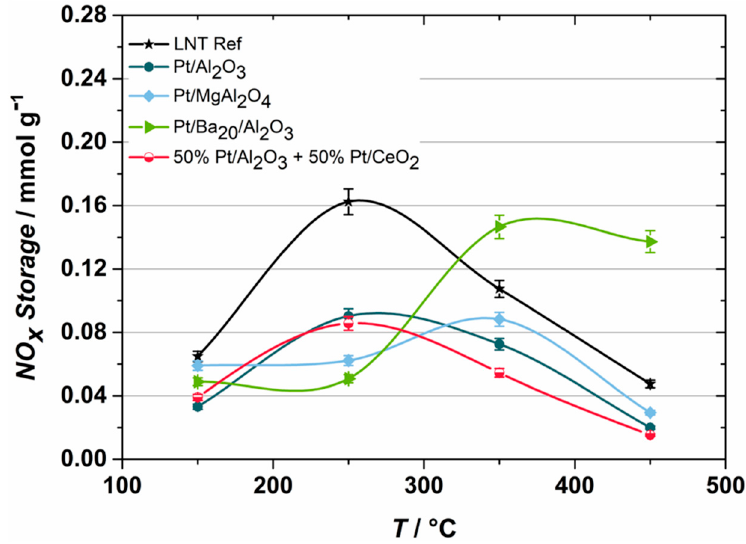
Figure 1. Temperature-dependent NO X storage capacity of individual materials and material com- binations compared to the fully formulated reference LNT.